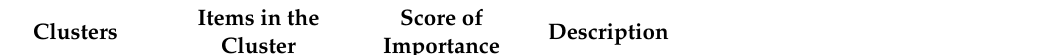
Table A3. Output of Data Coding Cycle, Final